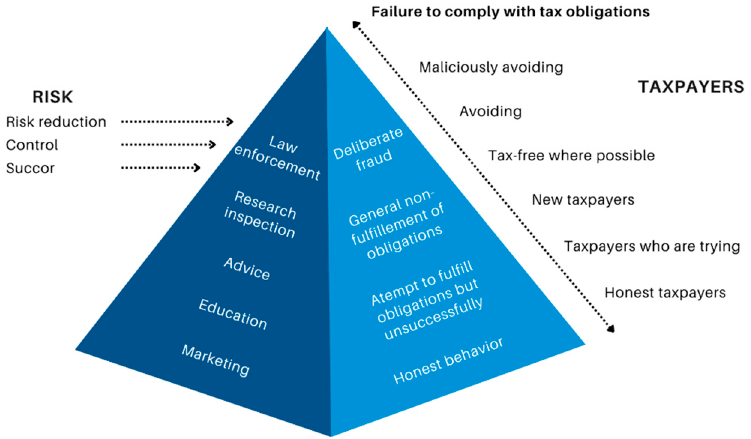
Figure 4. The execution of tax obligations [28].